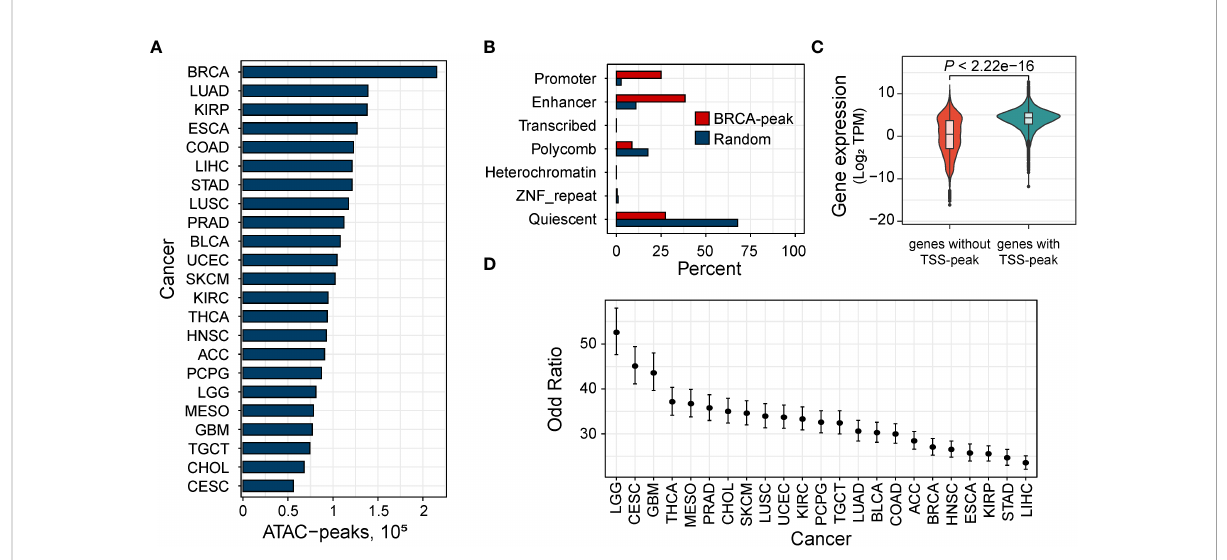
FIGURE 1 Open chromatin region related to regulatory elements. (A) Distribution of the number of the ATAC-peaks in 23 human cancers. BRCA, breast invasive carcinoma; KIRP, kidney renal papillary cell carcinoma; PRAD, prostate adenocarcinoma; COAD, colon adenocarcinoma; LUAD, lung adenocarcinoma; STAD, stomach adenocarcinoma; ESCA, esophageal carcinoma; LIHC, liver hepatocellular carcinoma; KIRC, kidney renal clear cell carcinoma; LUSC, lung squamous cell carcinoma; THCA, thyroid carcinoma; LGG, low-grade glioma; BLCA, bladder urothelial carcinoma; HNSC, head and neck squamous cell carcinoma; PCPG, pheochromocytoma and paraganglioma; TGCT, testicular germ cell tumors; ACC, adrenocortical carcinoma; MESO, mesothelioma; SKCM, skin cutaneous melanoma; UCEC, uterine corpus endometrial carcinoma; CHOL, cholangiocarcinoma; CESC, cervical squamous cell carcinoma; GBM, glioblastoma multiforme. (B) Percent of ATAC-peaks of breast carcinoma by chromatin state in breast tissue from the Roadmap Epigenomics Project. All peaks, red; randomly selected genomic regions. (C) Fisher ’ s test shows that expressed genes (median TPM > 1) are more likely to have an ATAC-peak overlapping the TSS. Error bars indicate 95% con fi dence intervals. (D) Comparison of the expression between genes expressed in BRCA with and without an ATAC-peak overlapping the